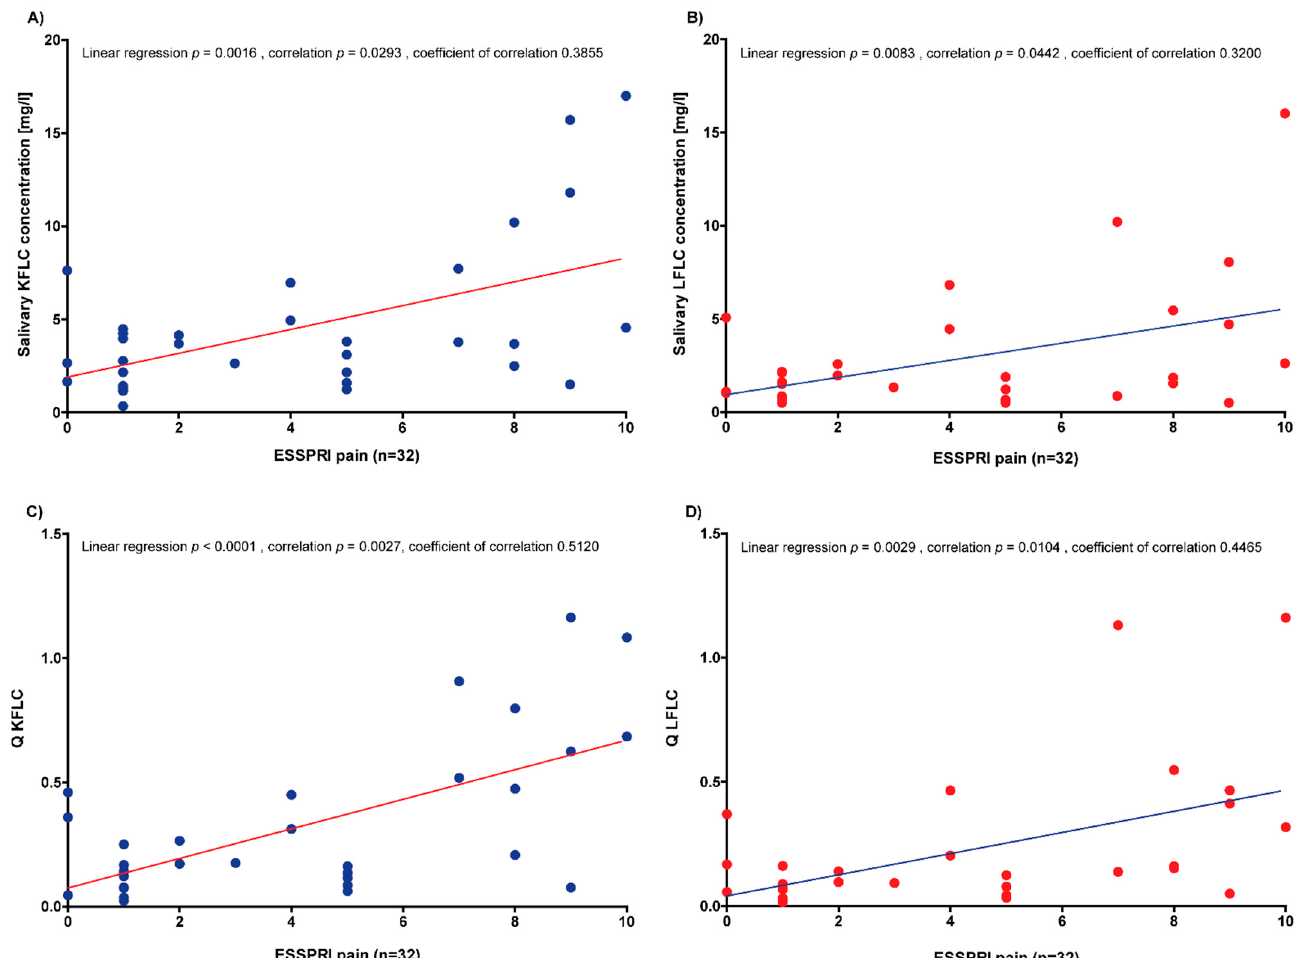
Figure 2. Correlation analyses of the saliva protein concentrations and quotients with the ESSPRI pain score. ( A ) KFLC = kappa free light chains; ( B ) LFLC = lambda free light chains; ESSPRI = EULAR Sjögren’s Syndrome Patient Reported Index; ( C ) Q KFLC = salivary/serum KFLC concentration quotient; ( D ) Q LFLC = salivary/serum LFLC concentration quotient.